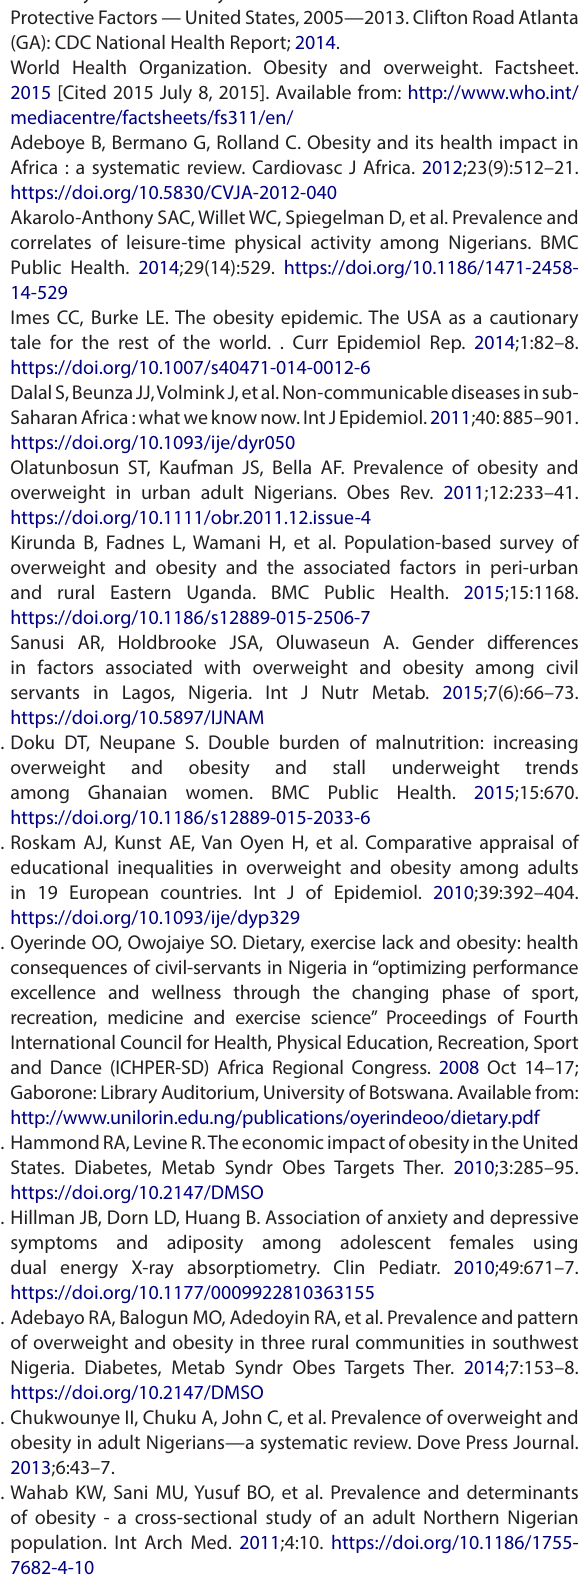
Table 3: Multivariate (LR Model) analysis on determinants of obesity